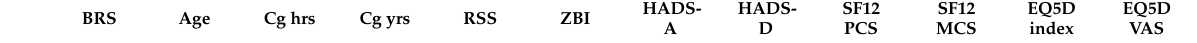
Table 5. Spearman correlation analyses among care partners’ characteristics ( n =